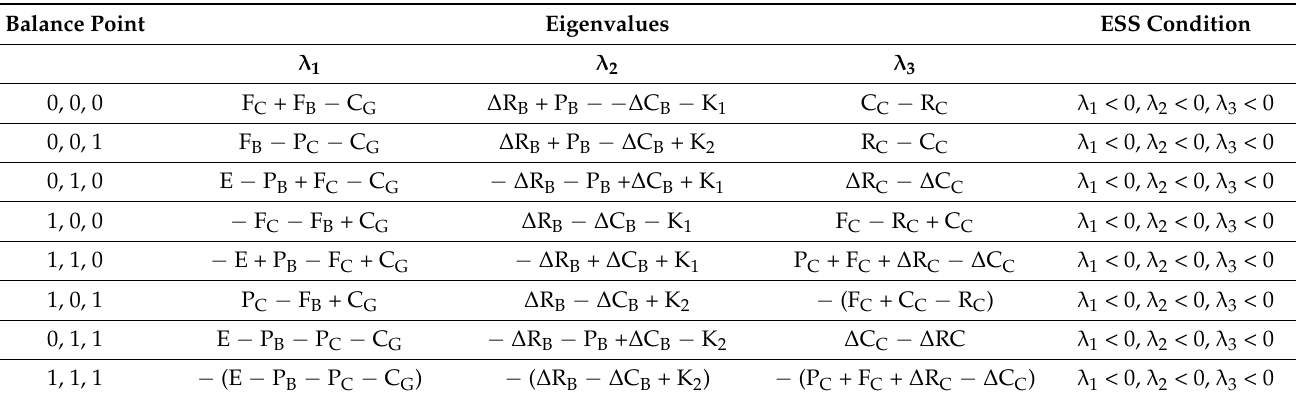
Table 2. Substitute the eight pure-strategy equilibrium points into the equation to obtain the following eigenvalue